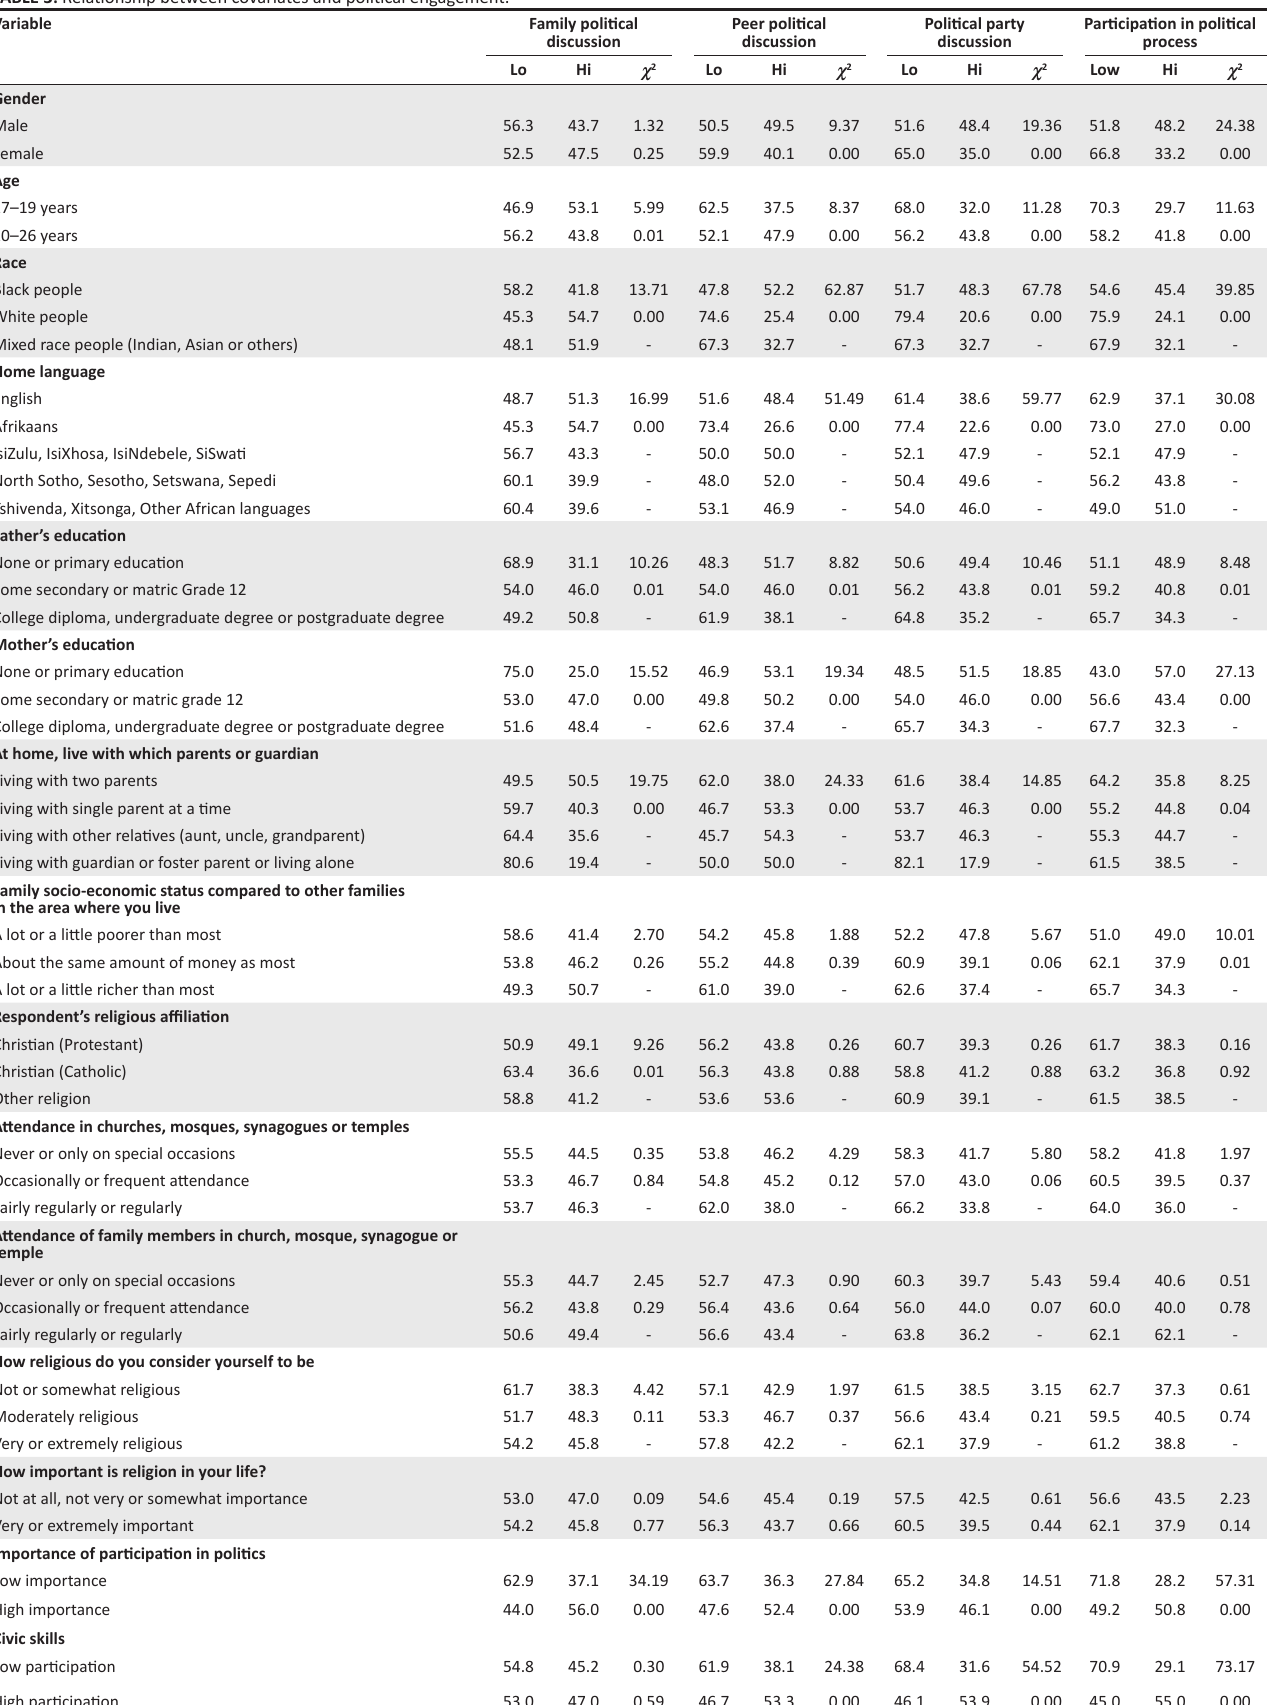
TABLE 3: Relationship between covariates and political engagement.